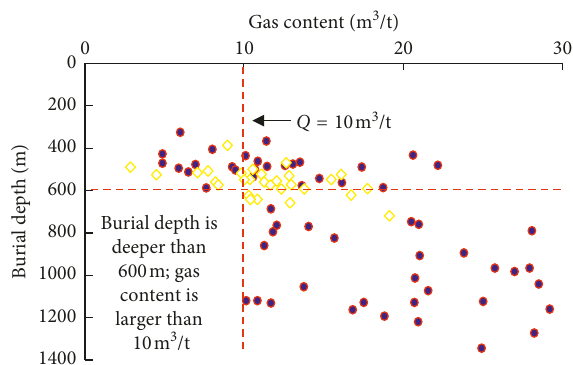
Figure 6: Relational graph of gas content and burial depth.